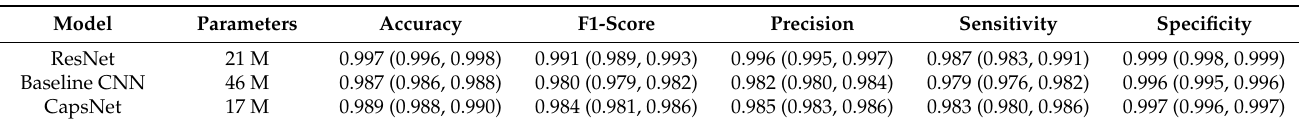
Table 2. Performance of the different models for dental radiograph classification (mean, 95% CI). Statistical significance between models is indicated in bold ( p < 0.05).